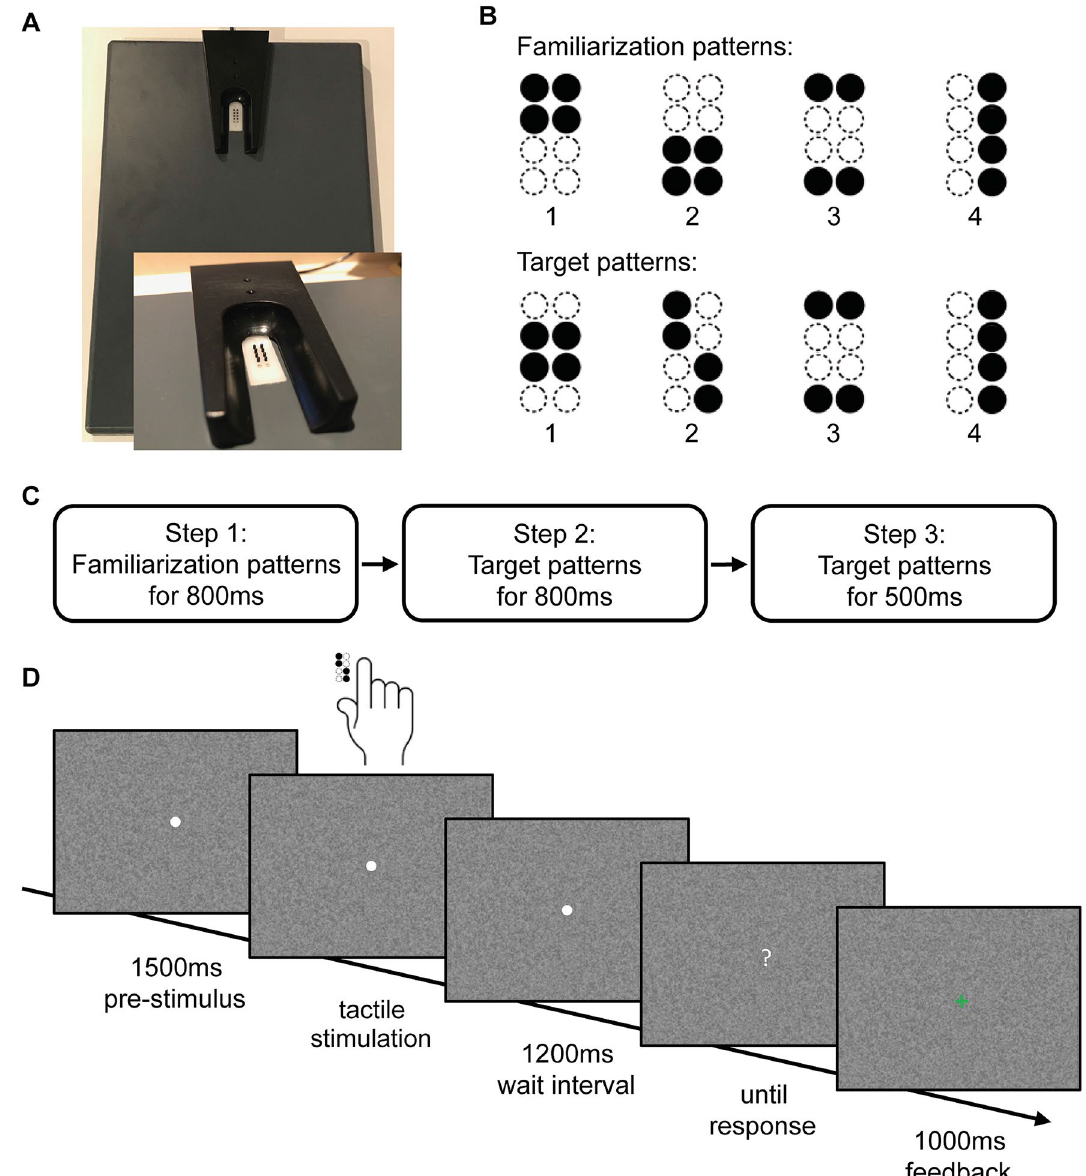
Figure 1. Stimulus design and experimental procedure. ( A ) Braille stimulator. For tactile stimulation, the participants’ right hand was resting on a custom-made board containing a Braille stimulator (QuaeroSys Medical Devices, Schotten, Germany), with the fingertip of the right index finger placed above the stimulating unit. The Braille stimulator consists of eight pins arranged in a four-by-two matrix, each 1 mm in diameter with a spacing of 2.5 mm. Each pin is independently controllable. ( B ) Stimuli consisted of two sets of four tactile patterns, ( C ) Sequence of tasks in the experiment, ( D ) The trial sequence. After a pre-stimulus interval of 1500 ms, tactile patterns were presented to the right index finger with a duration depending on the current step of the experiment. After a wait interval of 1200 ms, a question mark appeared on the screen and participants gave the response via button press. A visual feedback (1000 ms) was provided after every